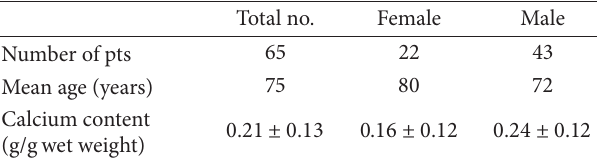
Table 1: Characteristics of patients (pts) and calcium content of the valves with AS. Calcium content of the valves was evaluated using biphotonic absorptiometry; results are expressed as mean ± SD. Total